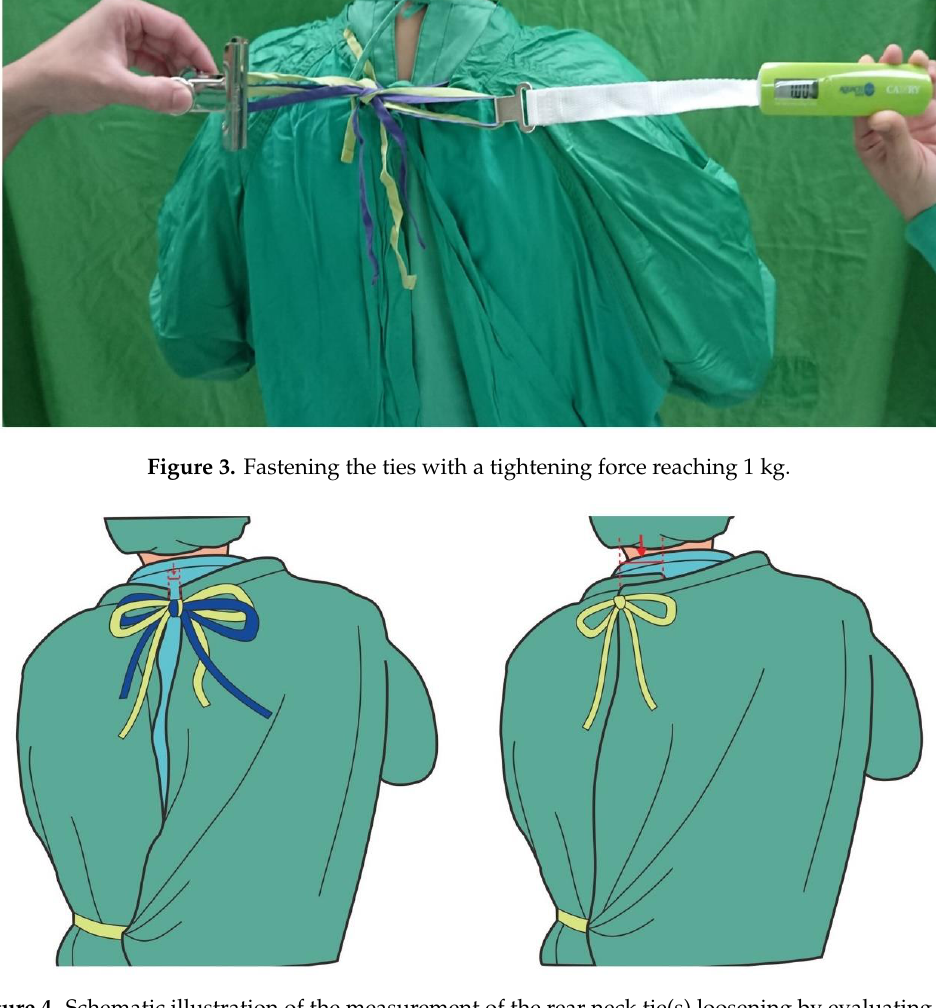
Figure 4. Schematic illustration of the measurement of the rear neck tie(s) loosening by evaluating the separation of the arrow-indicated distance before and after the exercise.